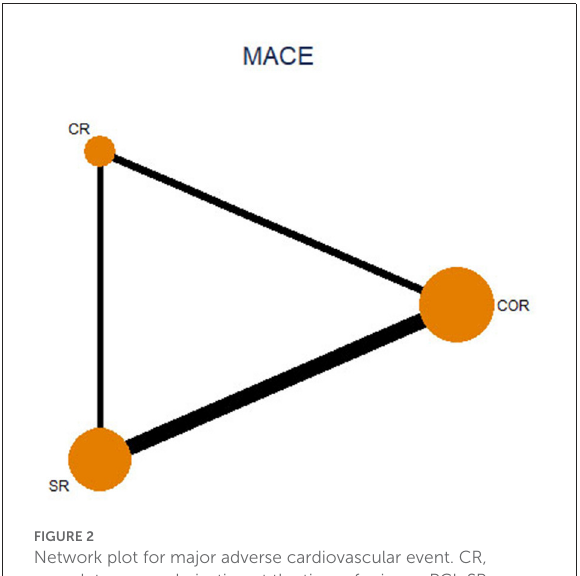
FIGURE2 Network plot for major adverse cardiovascular event. CR, complete revascularization at the time of primary PCI; SR, complete revascularization as a staged procedure; COR, culprit-only revascularization.